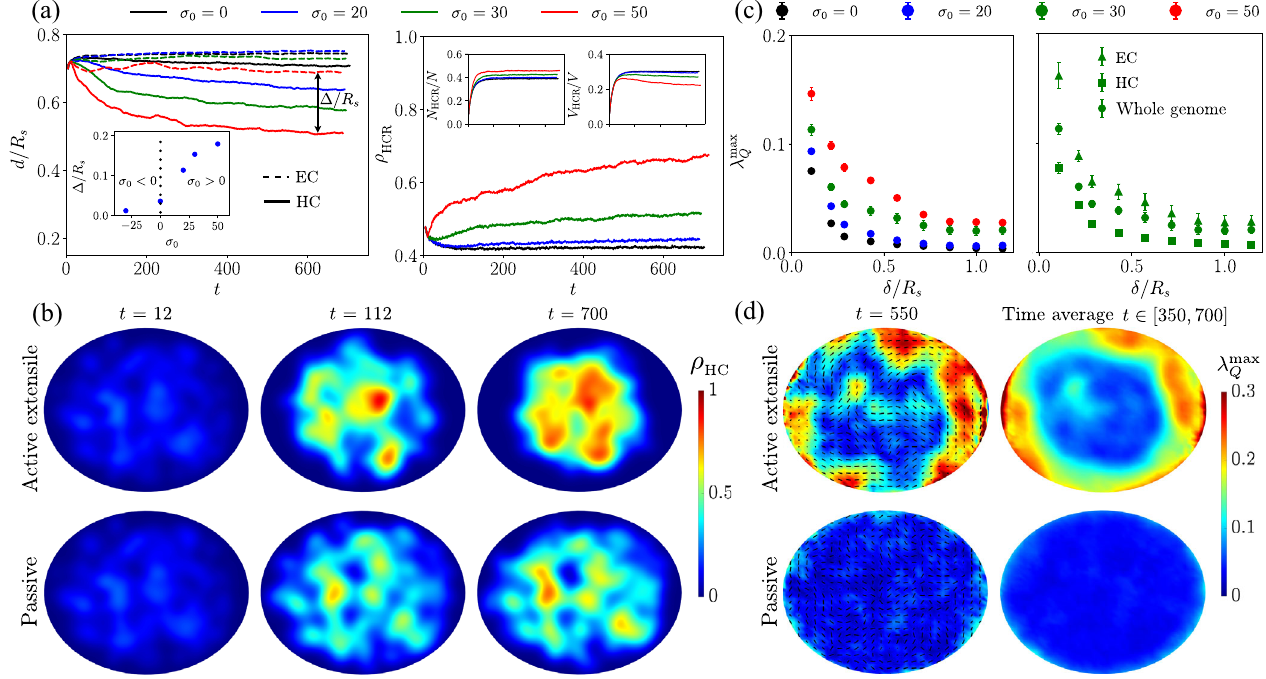
ffiffiffiffiffiffiffiffiffiffiffi p hj x j 2 i FIG. 3. Analysis of euchromatin and heterochromatin distribution in the nucleus. (a) Left: standard deviation d ¼ of the polymer mass distribution normalized by the equivalent nucleus radius R s for EC and HC blocks as a function of time, where HC blocks − d are seen to migrate toward the center of the system. The inset shows the migration offset, defined as Δ ¼ d , at steady state as a EC HC function of activity σ 0 . Right: mean density ρ of HCRs [see Fig. 2(c)]. Insets show the fraction of the number of beads contained in HCR HCRs, as well as the fraction of the total volume that they occupy. (b) For the simulations in Fig. 2, time snapshots of the heterochromatin density field in a plane containing the major axis of the nucleus, for the active euchromatin case ( σ 0 ¼ 30 , top row) and the passive euchromatin case ( σ 0 ¼ 0 , bottom row). (c) Left: nematic order parameter λ max Q , averaged over spheres of radius δ at late times, for various levels of activity σ 0 . Right: nematic order parameter for EC blocks, HC blocks, and for the whole genome, in simulations with σ ¼ 30 . (d) For the same simulations as shown in Fig. 2, the structure of nematic alignment for δ ¼ 5 in a plane containing the major 0 axis of the nucleus, for the active euchromatin case ( σ 0 ¼ 30 , top row) and the passive euchromatin case ( σ 0 ¼ 0 , bottom row). The color map is of the scalar nematic order parameter, while black segments depict the nematic director projected onto the viewing plane. The left- hand column shows a snapshot at t ¼ 550 , whereas the right-hand column shows a time average for t ∈ ½ 350 ; 700 (cid:2)